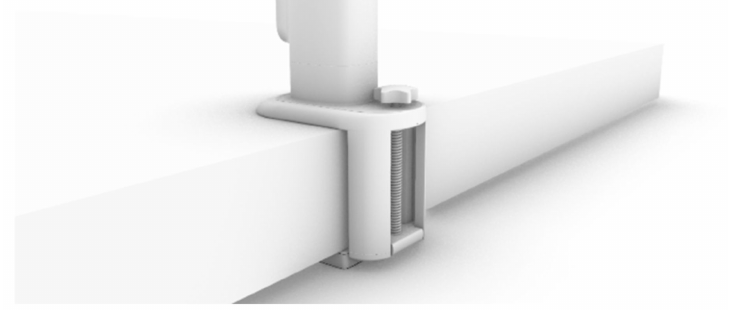
Figure 18. Fixed base.